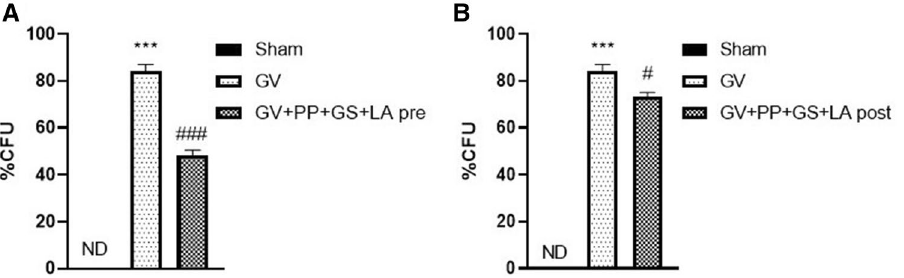
post-treatment condition ( B ). ( A ) *** p < 0.001 vs Sham; ### p < 0.001 vs GV group; ( B ) *** p < 0.001 vs Sham; # p < 0.05 vs GV